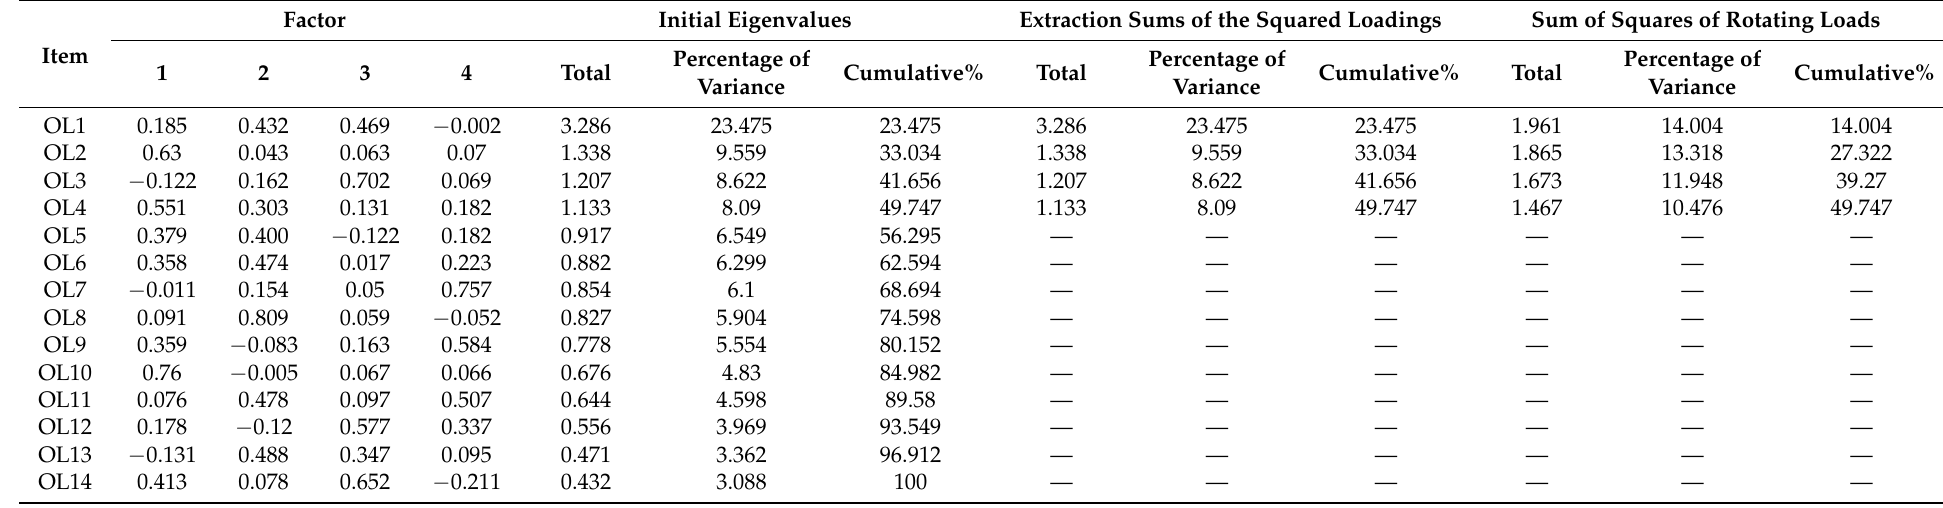
Table 4. Exploratory factor analysis results of organizational